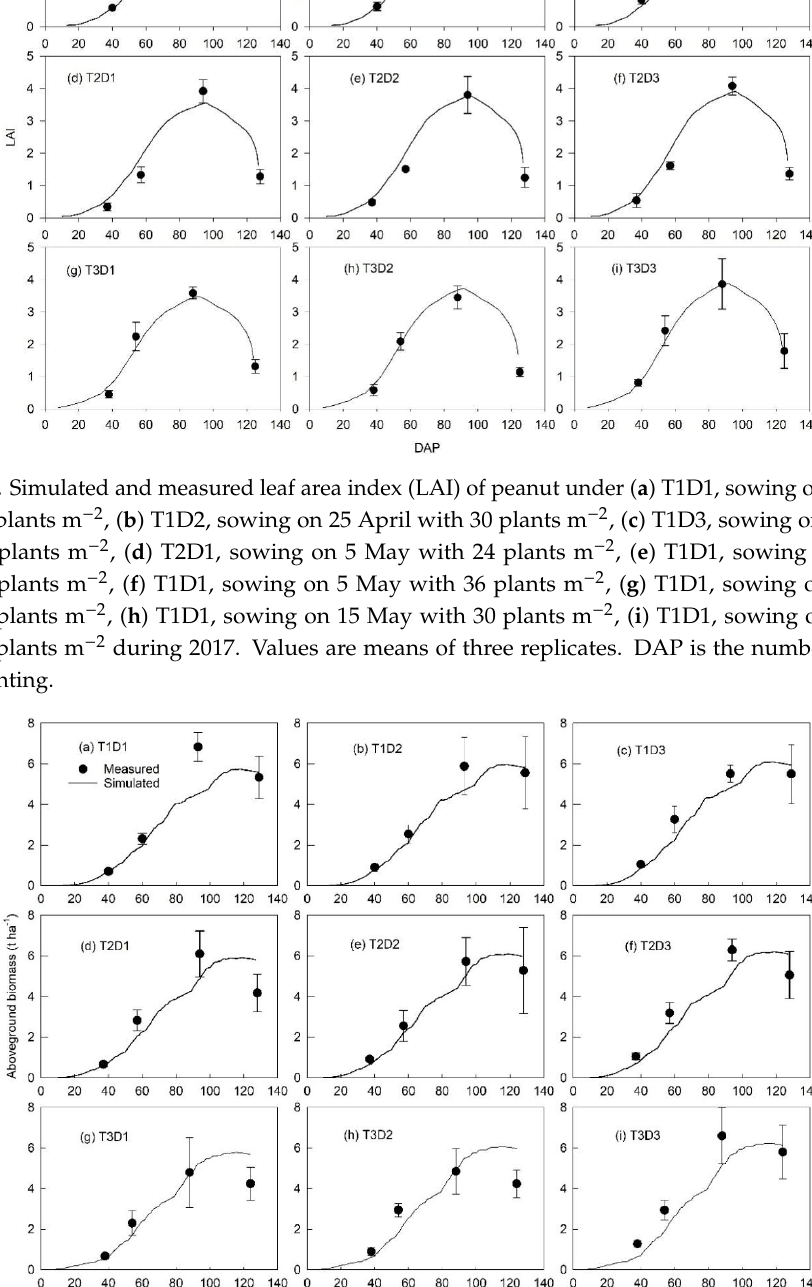
Figure 6. Simulated and measured aboveground biomass of peanut under (a) T1D1, sowing on 25 April with 24 plants m −2 , (b) T1D2, sowing on 25 April with 30 plants m −2 , (c) T1D3, sowing on 25 April with 36 plants m −2 , (d) T2D1, sowing on 5 May with 24 plants m −2 , (e) T1D1, sowing on 5 May with 30 plants m −2 , (f) T1D1, sowing on 5 May with 36 plants m −2 , (g) T1D1, sowing on 15 May with 24 plants m −2 , (h) T1D1, sowing on 15 May with 30 plants m −2 , (i) T1D1, sowing on 15 May with 36 plants m −2 during 2017. Values are means of three replicates. DAP is the number of days after planting.